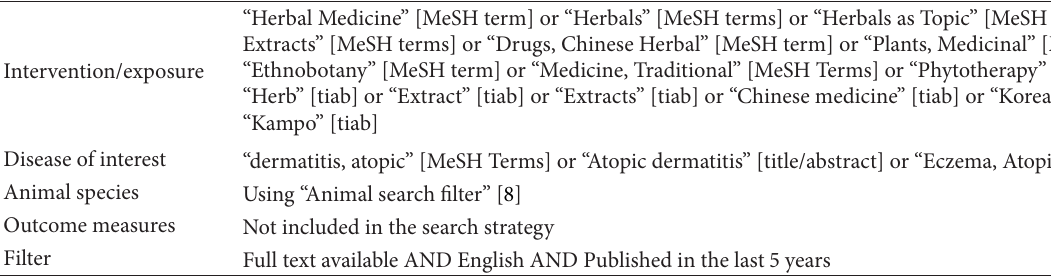
Table 1: Search strategy for PubMed.